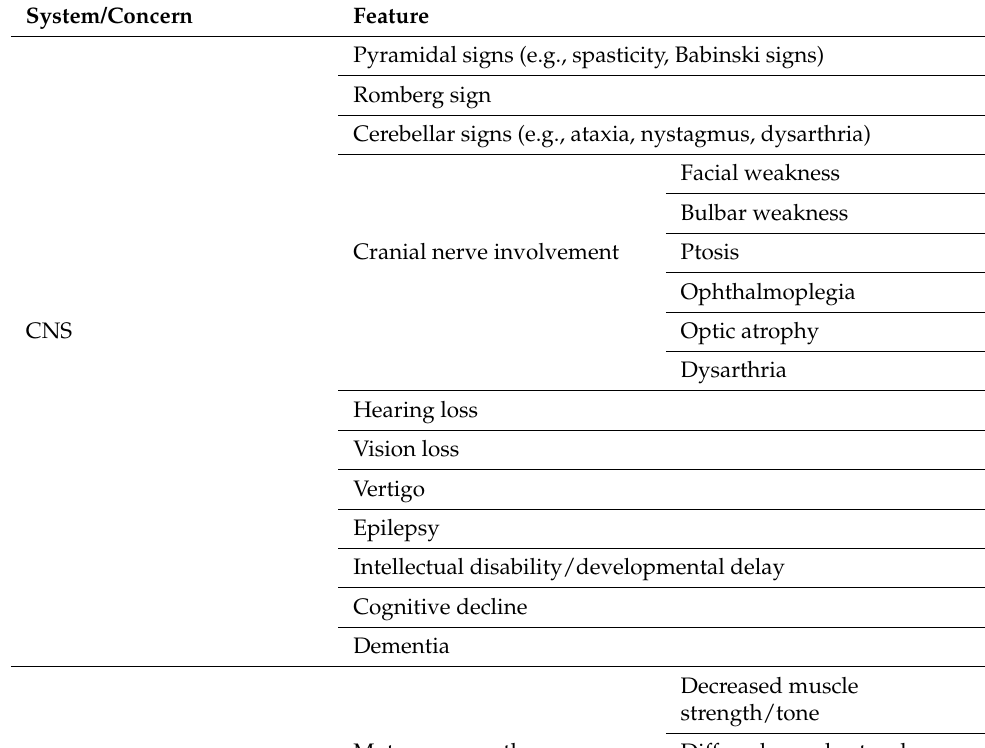
Table 2. General categorization of clinical phenotypes observed in individuals with classical giant axonal neuropathy. Multiple systems are often involved to reflect a certain symptom